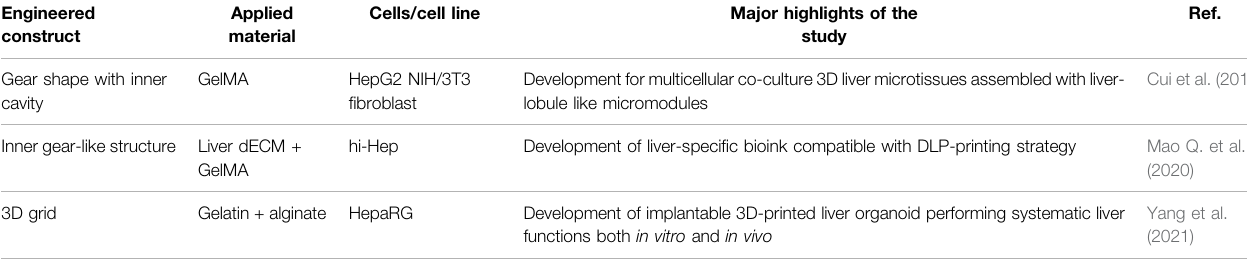
TABLE 3 | Single structure of multicomponent bioink-based 3D-printed liver tissue models for liver regeneration models. Engineered construct